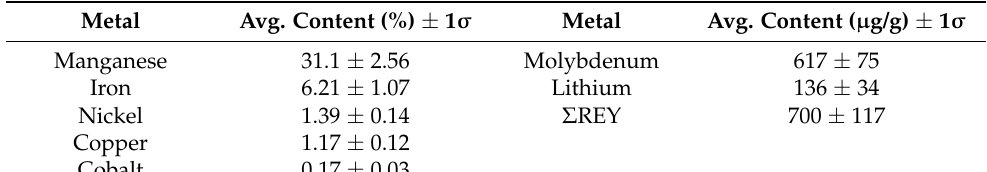
Table 2. Average metal contents determined on 741 nodule samples in Area E1.